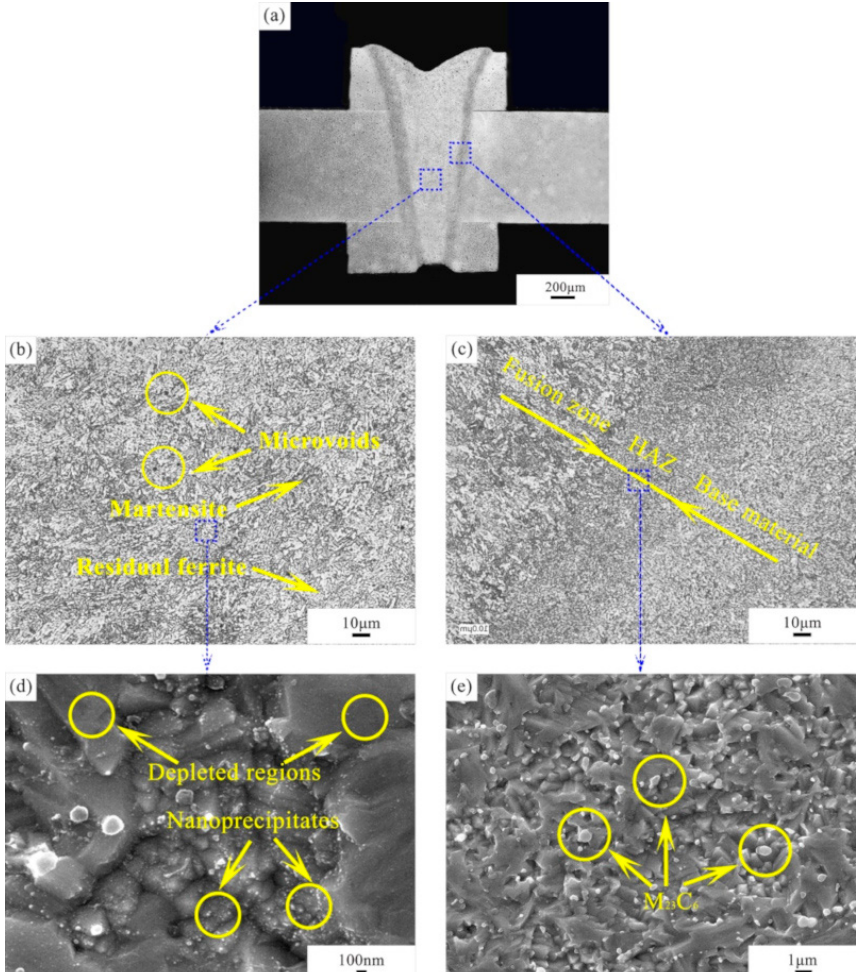
Figure 4. Morphologies of the weld seam with filler material: ( a ) SEM morphology of the weld seam, ( b ) fusion zone, ( c ) fusion line, ( d ) enlarged fusion zone and ( e ) enlarged HAZ.